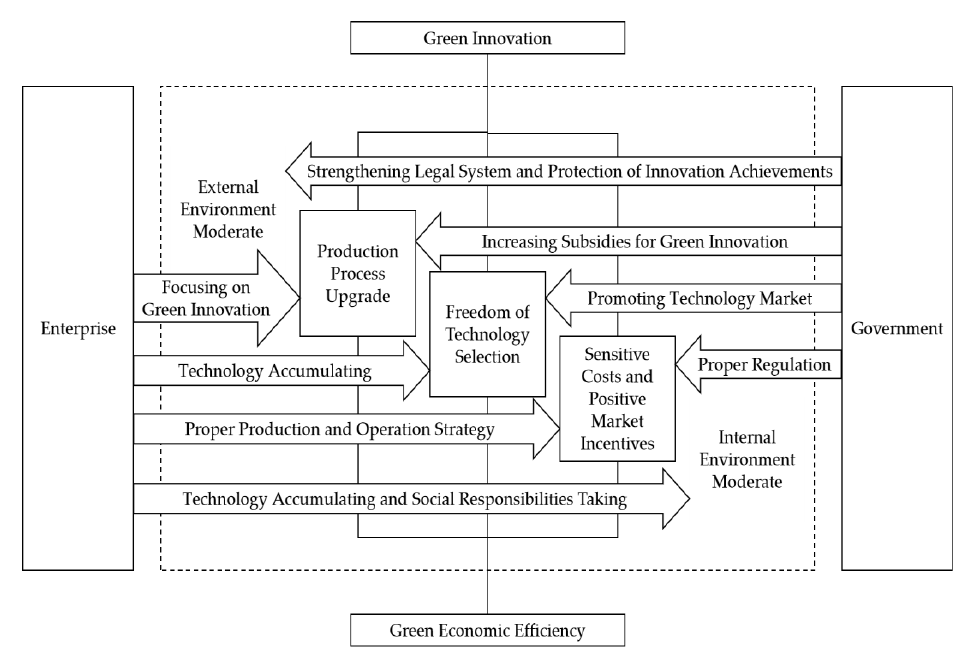
Figure 2. Effects of government support and enterprise strategy.